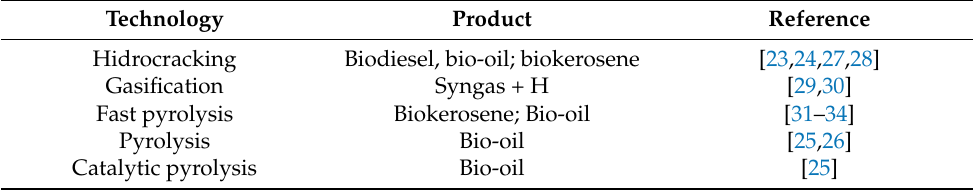
Table 3. Alternative technologies used for biofuel production through